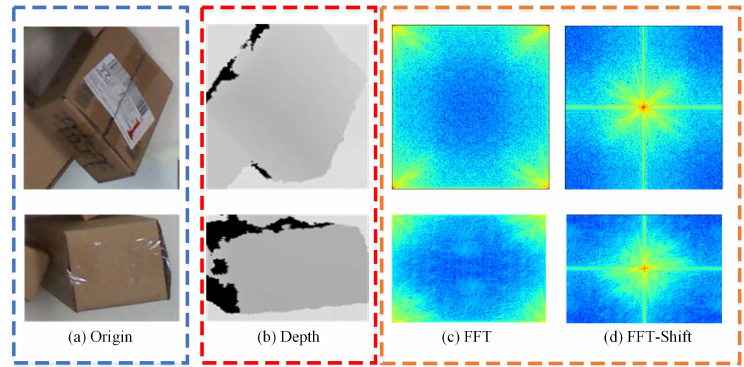
Figure 6. Multi-modal supervision signal in MS-ST. Third, the occlusion degree of the sorting region is a key factor in judging the sorting order. The subsequent experiments demonstrate that using the occlusion degree as a supervision signal can also effectively improve the segmentation accuracy of the target regions. As shown in Figure 7. Origin donates the original image of the object to be sorted. Red represents the pickable region, and green represents the unpickable region. Mask represents the pickable and unpickable region of the object to be sorted. Additionally, Complete represents the complete region of sorting plane. Before the network training, we labeled the complete regions of stacked parcels in our dataset based on our perception. The occlusion degree is the result of dividing the number of pixels in the pickable region by the number of pixels in the complete region.